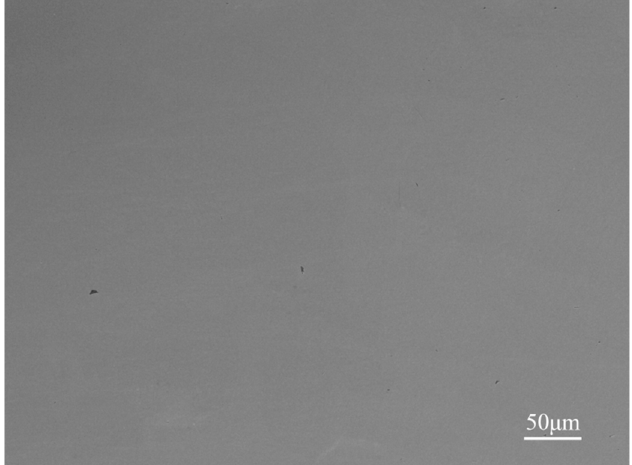
Figure 7. SEM image of the HEAs used powders with high granule density.